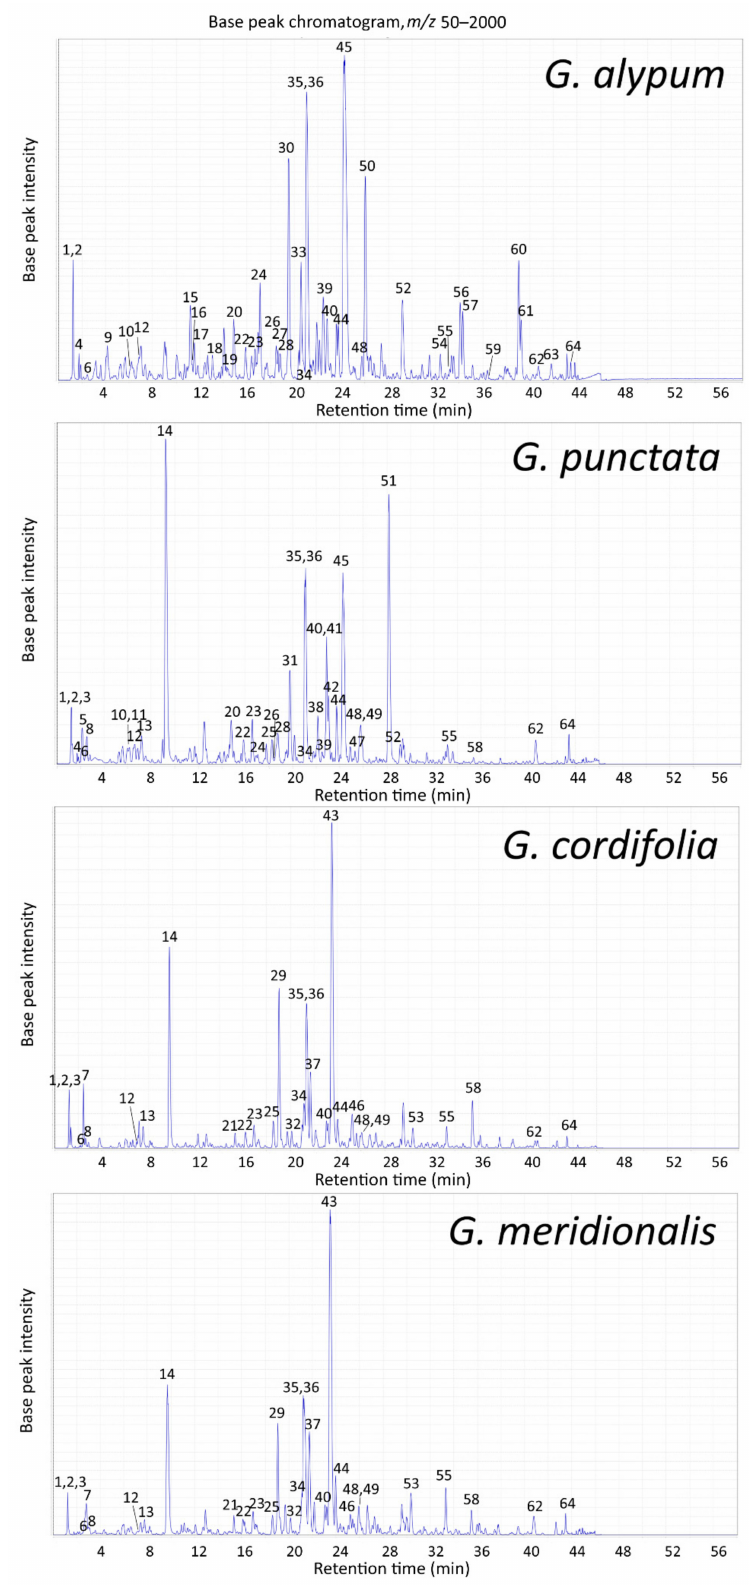
Figure 1. LC-MS base peak chromatograms of methanolic leaf extracts from G. alypum , G. punctata , G. cordifolia and G. meridionalis obtained by ultrasound-assisted extraction. Numbers on chro- matograms refer to compounds listed in Table